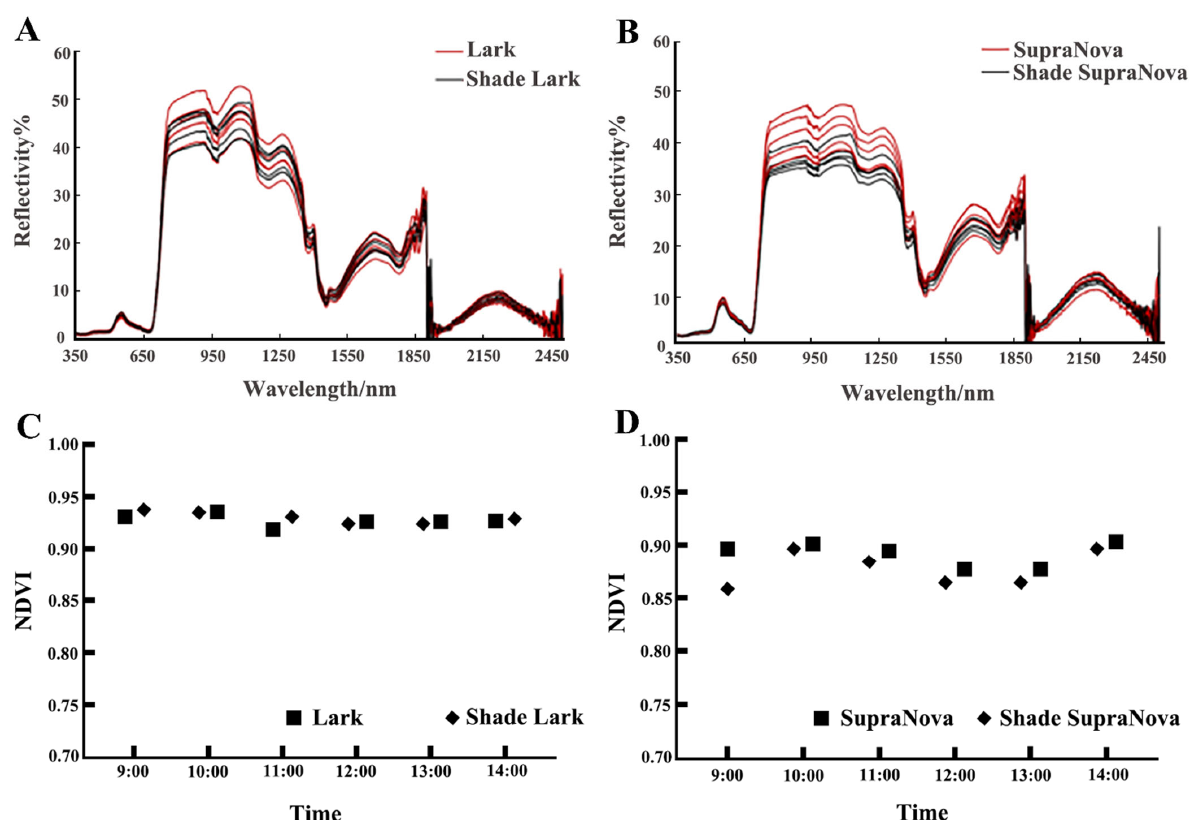
Figure 3. Diurnal variation in the spectrum ( A , B ) and normalized difference vegetation index (NDVI) diurnal variation ( C , D ) of the two species.